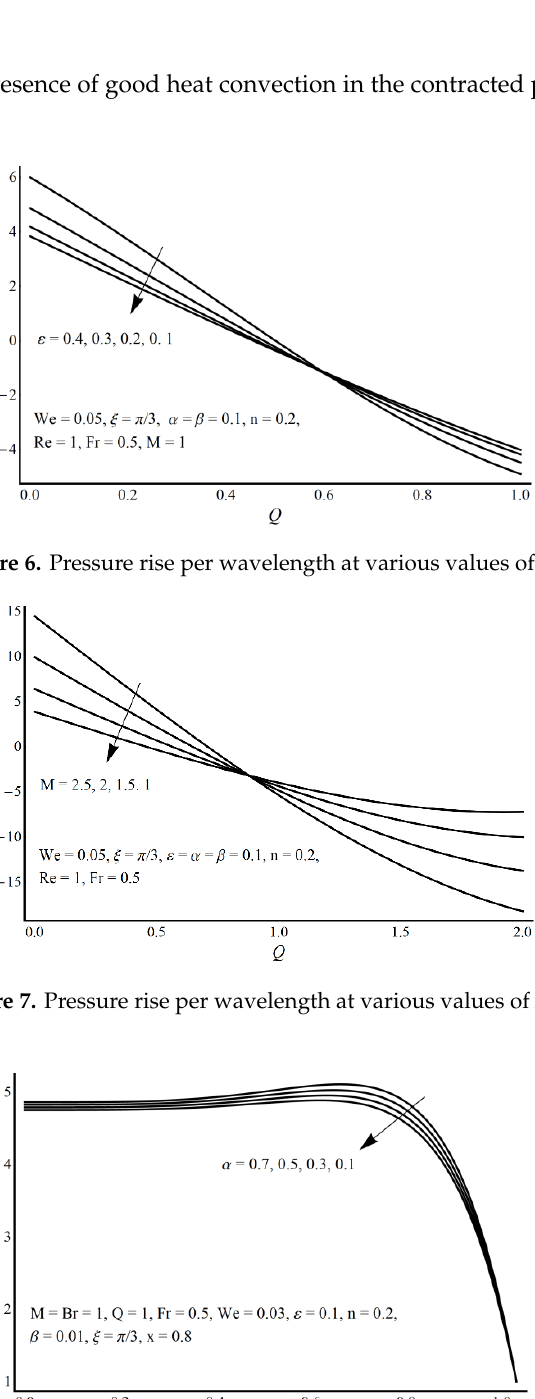
Figure 4. A 3D velocity profile when M = 1, n = α = 0.2, We 2 = 0.03, ε = β = 0.1, ξ = π/3, Fr = 0.5.